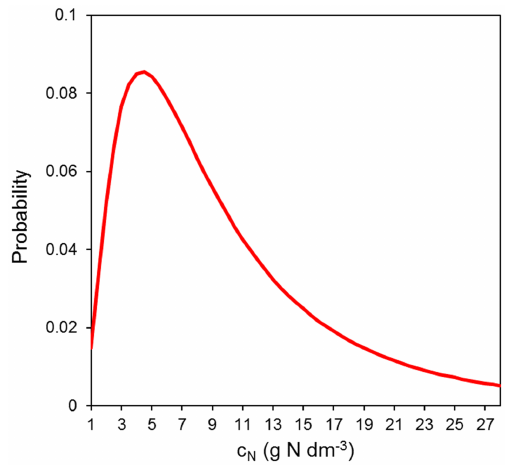
Figure 7. Probability density function of the log-normal distribution generated for the distribution of the nitrogen content of urine ( c N ) . The scale parameters are σ = 0.786 and µ =